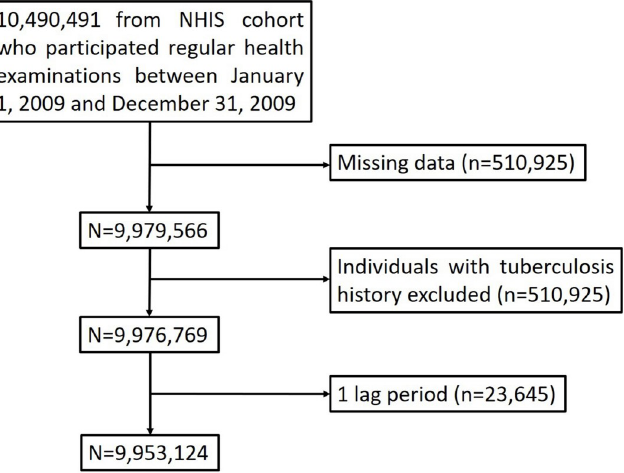
Fig 1. Flow chart of the study population. 9,943,124 participants were enrolled in this study. They were followed up until December 31, 2017. NHIS, national health insurance service.